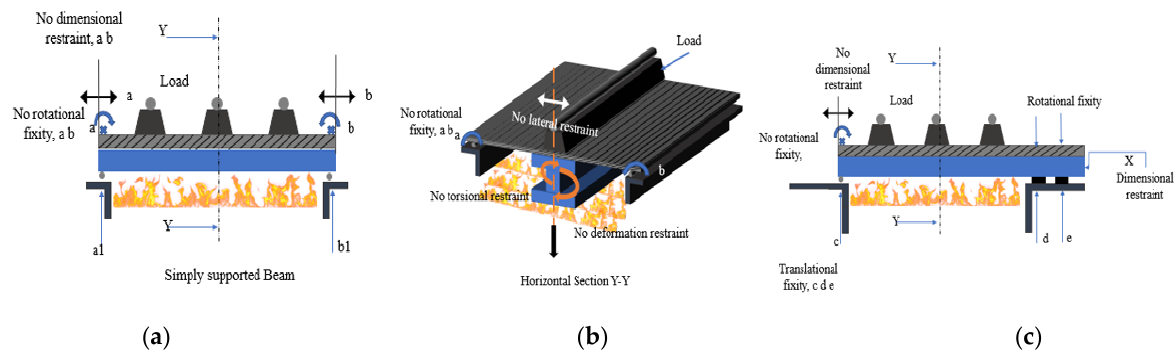
Figure 9. Restraints for beams: ( a ) 2D, ( b ) section, and ( c ) beam fixed at one end.